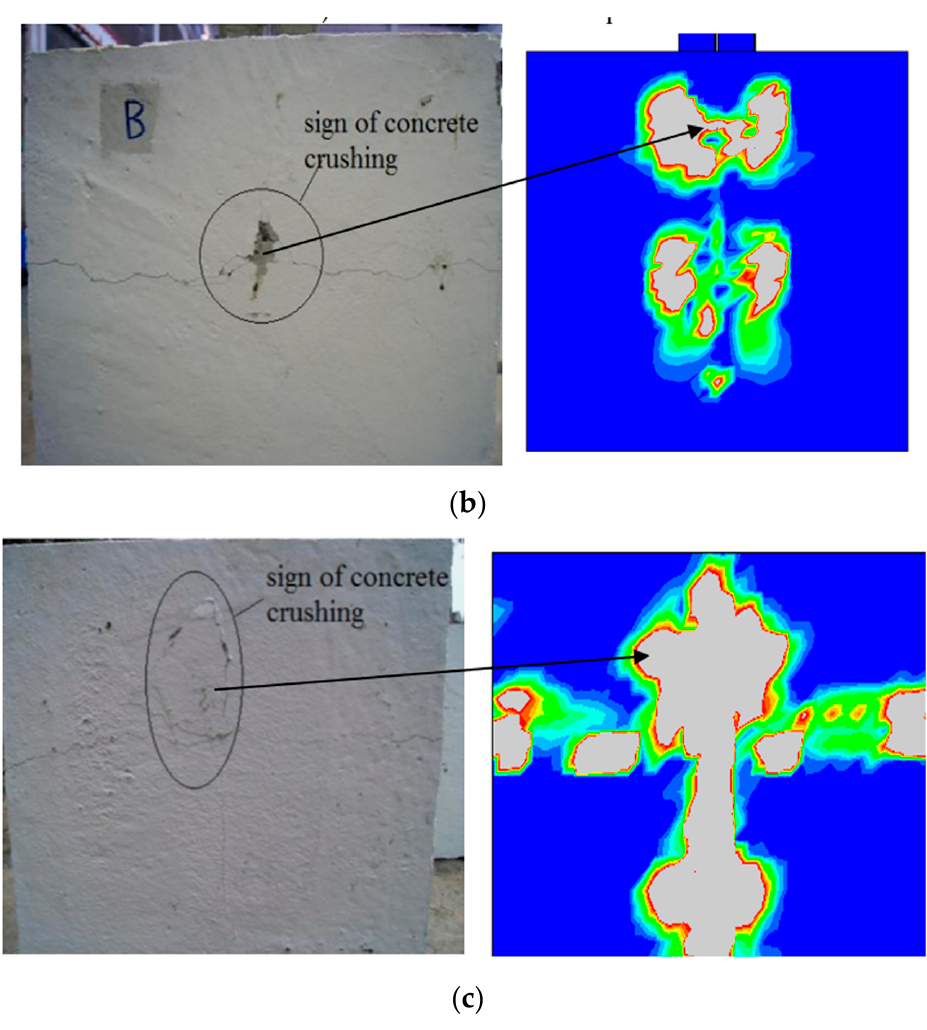
Figure 6. Failure modes of push test specimens compared to proposed FE model. ( a ) Failure mode of SBSC specimen. ( b ) Failure mode of DBSC specimen. ( c ) Failure mode of HPSC specimen. In the test, it was found that SBSC, DBSC, and HPSC shear connectors were rotated (a very small rotation). As a consequence of the initial rotation of SBSC and DBSC shear connectors, the shear connector was deformed, as can be seen from Figure 7a,b. For HPSC shear connectors, no deformation on the part of the shear connector embedded in the con- crete slab was observed, as can be seen from Figure 7c.